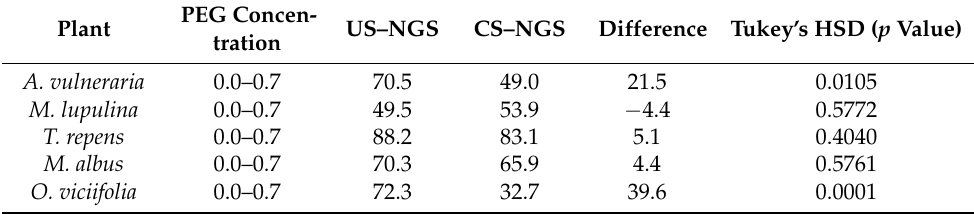
Table A2. Results of Tukey’s HSD test—GS, all plants.